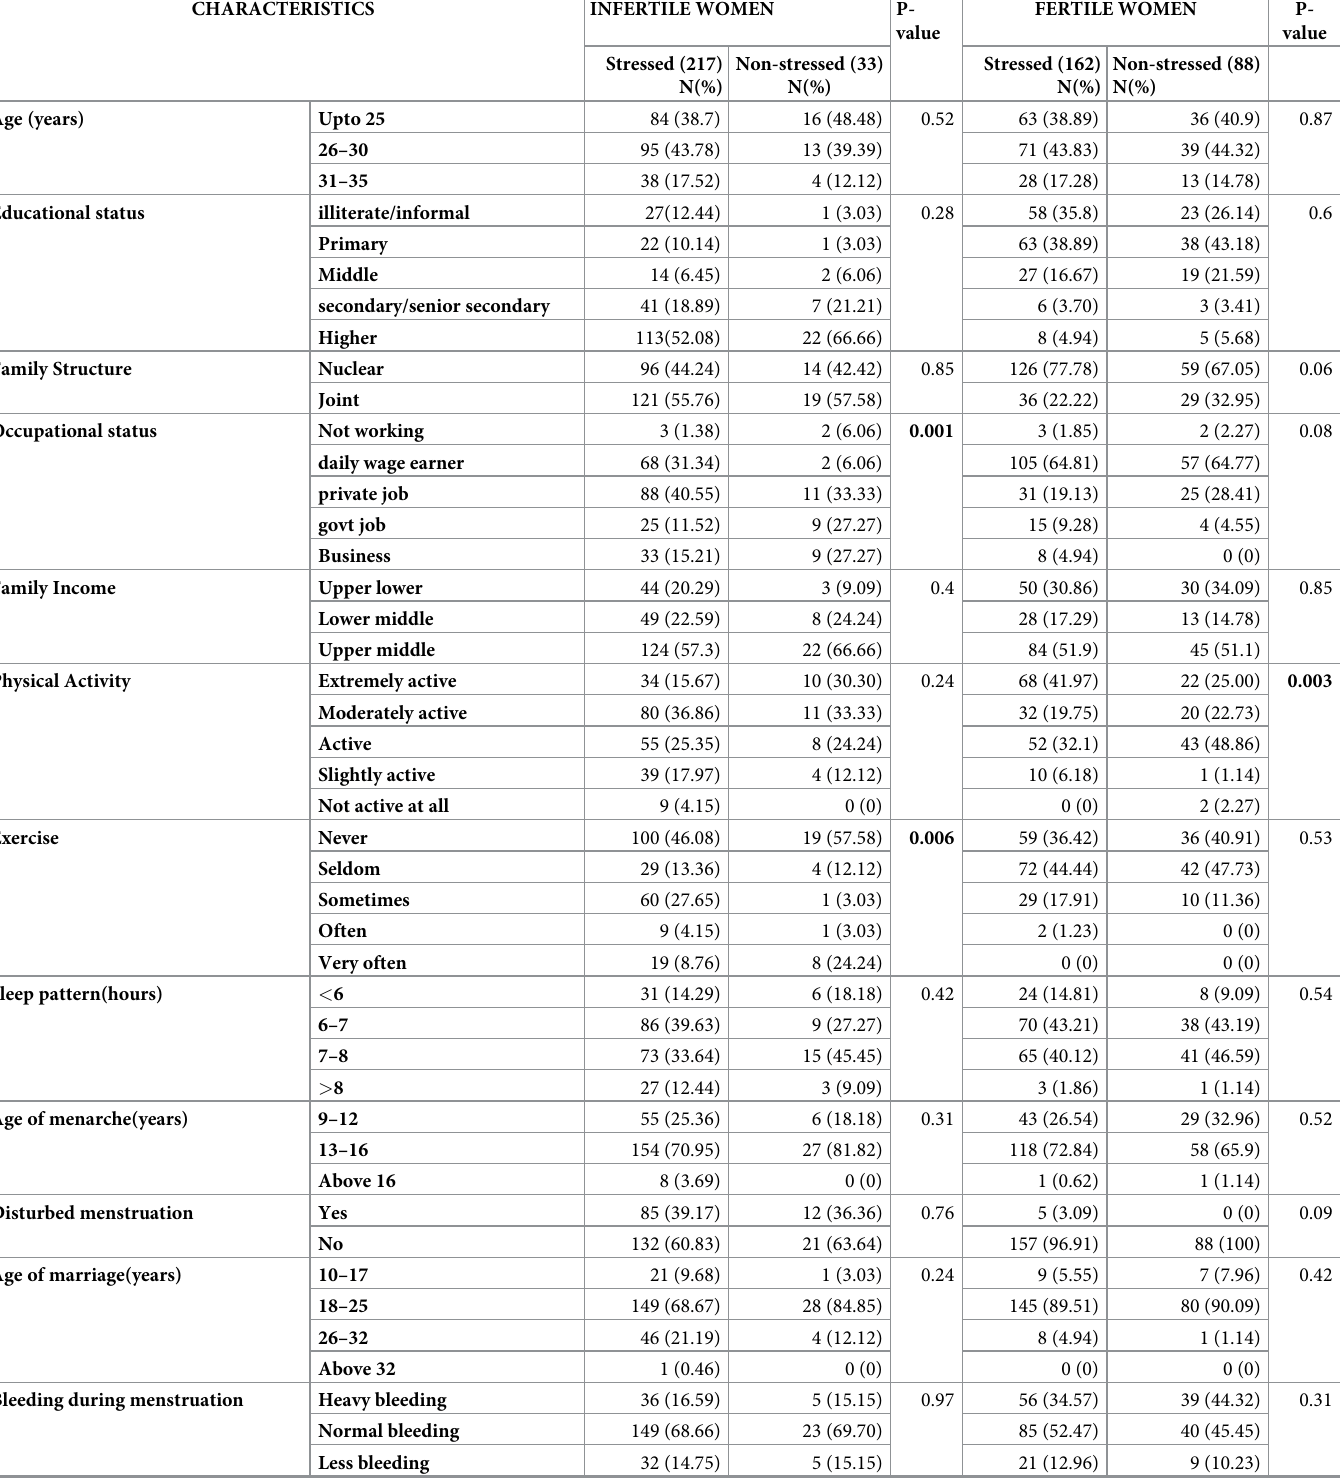
Table 3. Distribution of demographic, lifestyle variables and reproductive trajectories in infertile and fertile women in stress category.